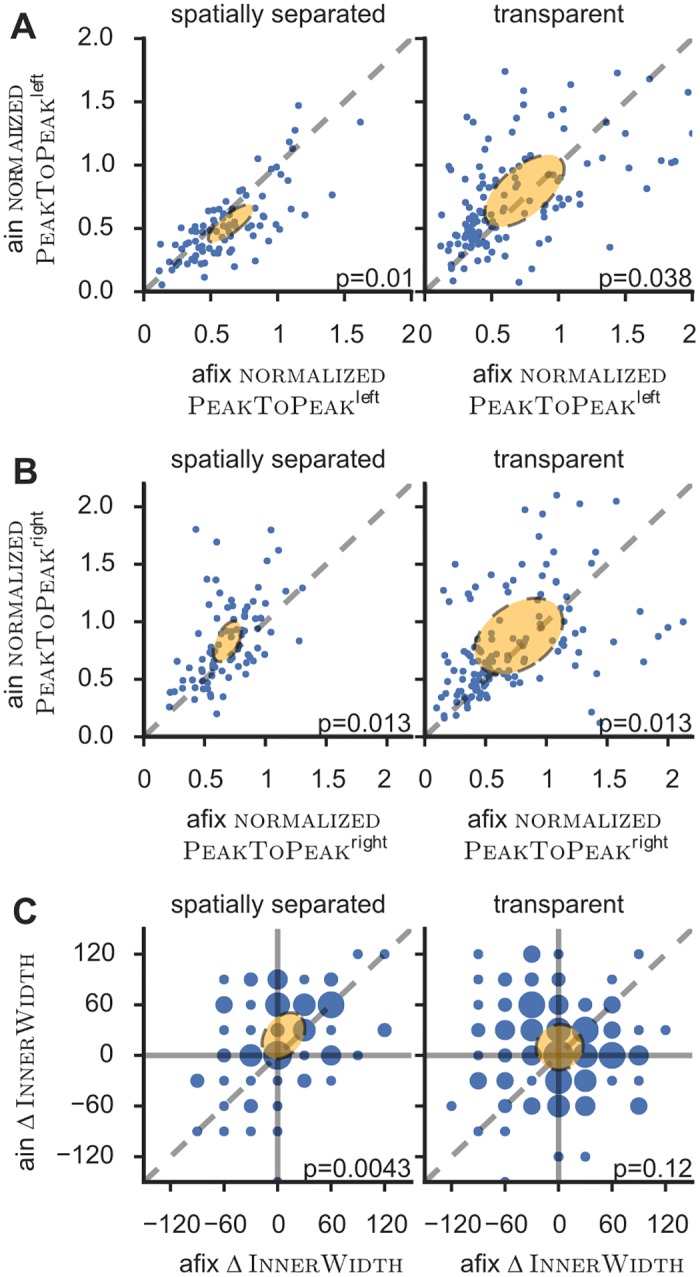
Effects of attention on tuning curves.Scatter plots of various features in the afix versus the ain condition. Orange error ellipses are centered on the mean feature values with half-axes corresponding to eigenvalues and -vectors of the feature-pair’s covariance matrix. Some outliers were omitted for better visualization. The indicated p-value in each panel corresponds to a Kruskal-Wallis test. A) Attention decreased (increased) the left peak—as measured by the feature normalizedPeakToPeakleft—in the spatially separated (transparent) paradigm. B) Attention increased the right peak in both paradigms according to the feature normalizedPeakToPeakright. C) Attention significantly increased the difference between left and right peak’s inner width—ΔInnerWidth—only for the spatially separated paradigm. Size of circles in panel C illustrates density of points at each particular coordinate (note that values of ΔInnerWidth from the direct method are quantized in steps of 30°due to the design of experimentally used stimuli). Altogether panels indicate that attention asymetrically expanded the right at the expense of the left peak for the spatially separated paradigm, but increased both peaks similarly for the transparent paradigm.